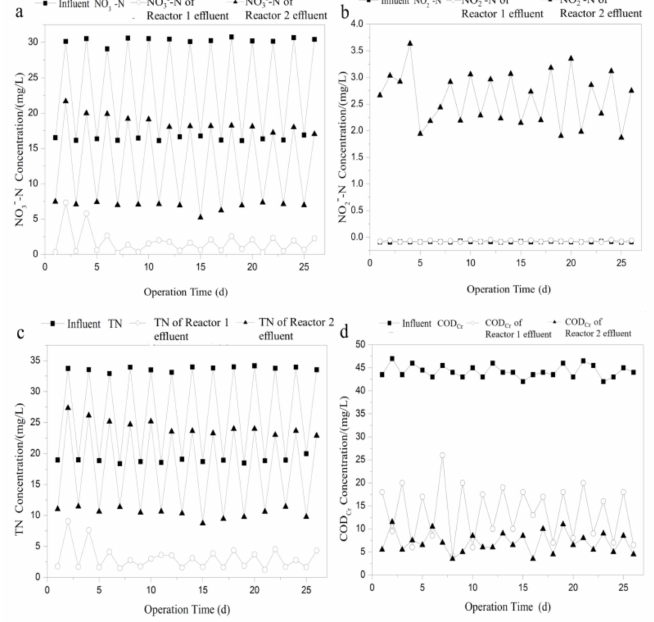
Figure 8. Influence of nitrate shock loading on e ffl uent: ( a ) nitrate; ( b ) nitrite; ( c ) TN; and ( d ) COD Cr concentration of the two